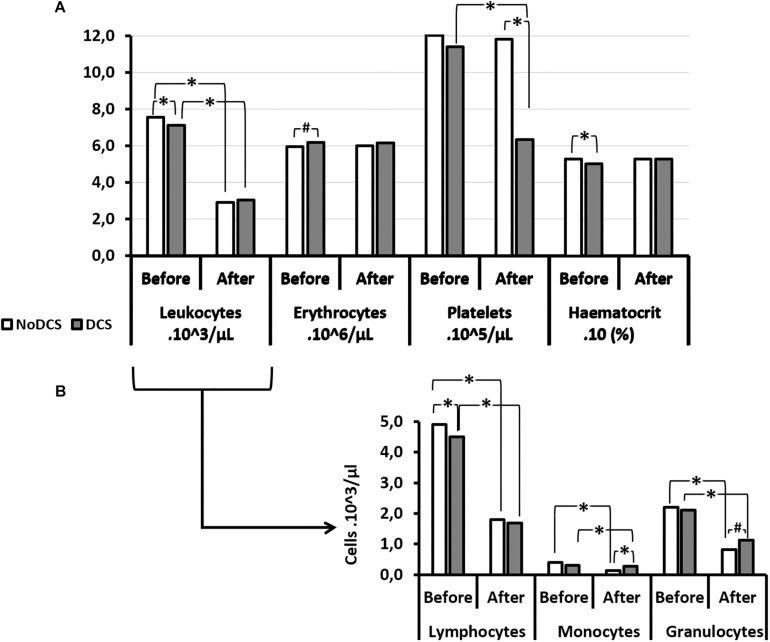
Blood cell count (A) and its leukocytes details (B) before and after the hyperbaric exposure, according to the clinical outcome. As results showed haemoconcentration linked to the hyperbaric exposure, the blood parameters registered after the dive were corrected individually depending on the variation in the haematocrit (notify by “c”), and then compared to the first blood punctures to present their changes (%): *Notes significant difference (p < 0.05) and # denotes p < 0.10 (trend) between NoDCS and DCS groups for the same paramete. NoDCS, mice without symptom of decompression sickness (white blocks); DCS, mice displaying symptoms of decompression sickness (gray blocks).